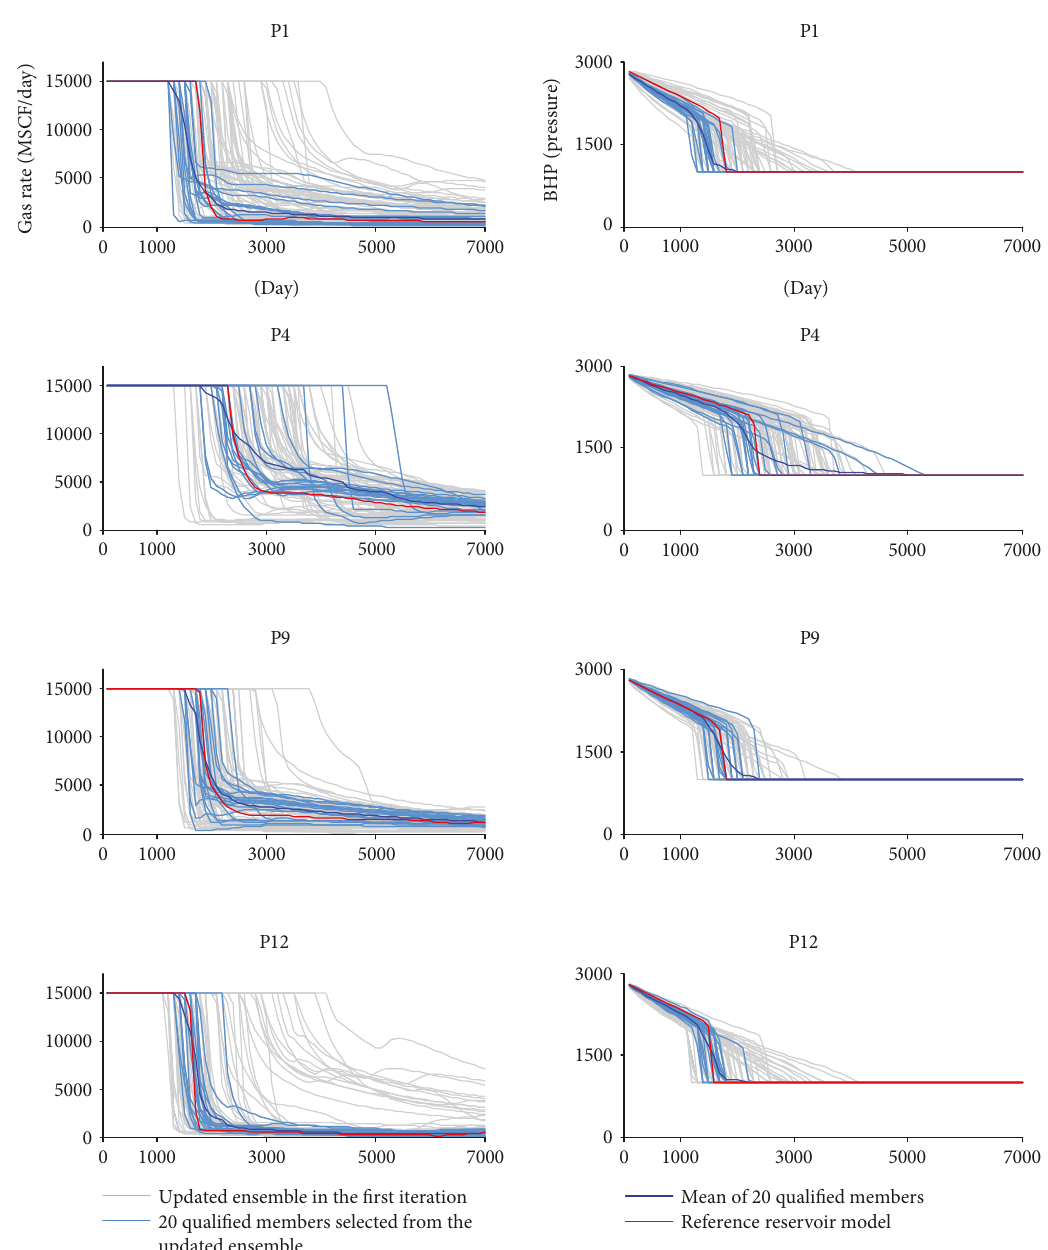
Figure 4: Gas rate and BHP pro fi les of 20 quali fi ed realizations selected from the updated ensemble after the fi rst